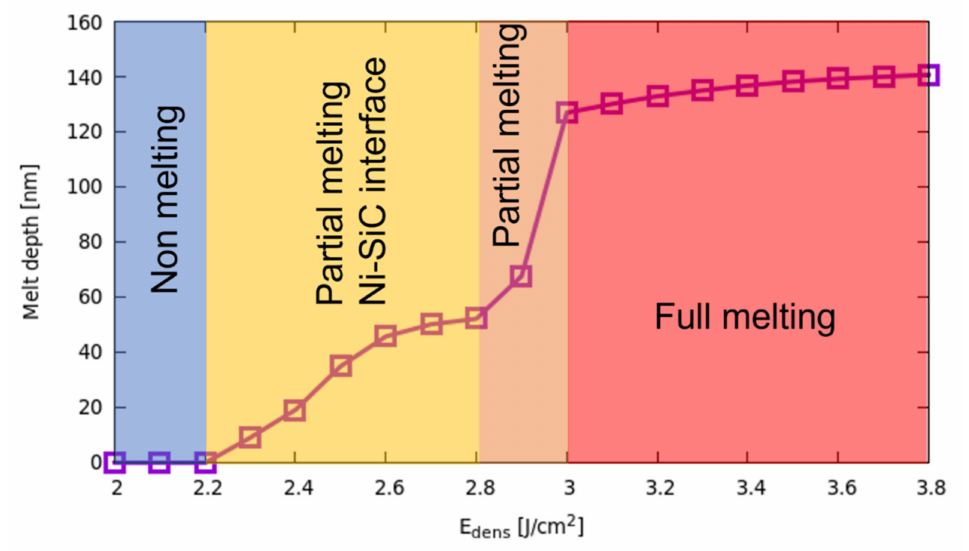
Figure 7. Maximum melting extension D max ( E dens ) (melt depth for fluence E dens > 2.8 J/cm 2 ) as a function of the fluence for an irradiated Ni-4HSiC stack. The different regimes (non-melting, partial melting at the Ni-SiC interface, partial melting at the surface, full melting) are indicated by means of the colored